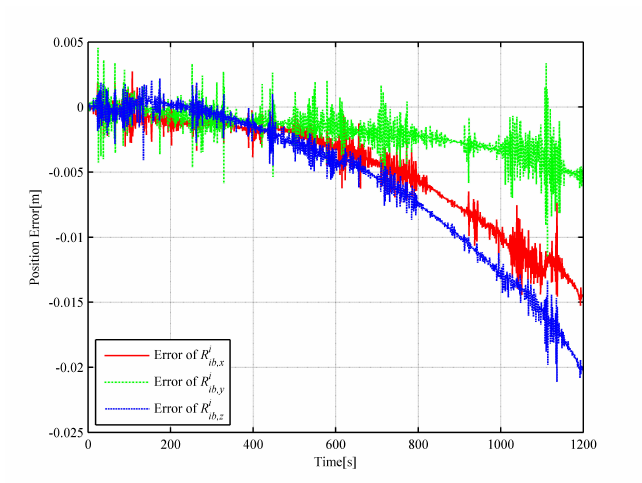
Figure 4. Curve of the position error (based on DQ).